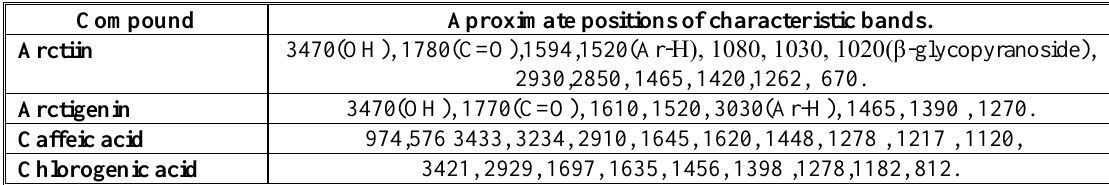
Table 4: IR absorption bands of isolated compounds ( in cm -1 ).